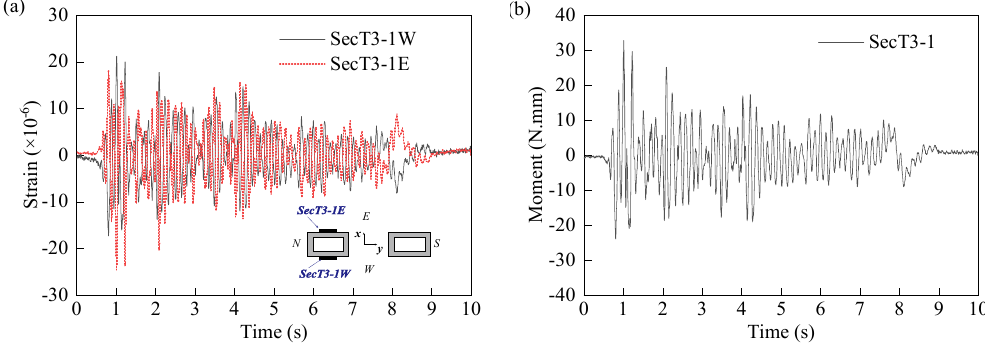
Figure 18. Seismic response of sectionT3-1 under ScEL ( a ) Strain response; ( b ) Bending moment.